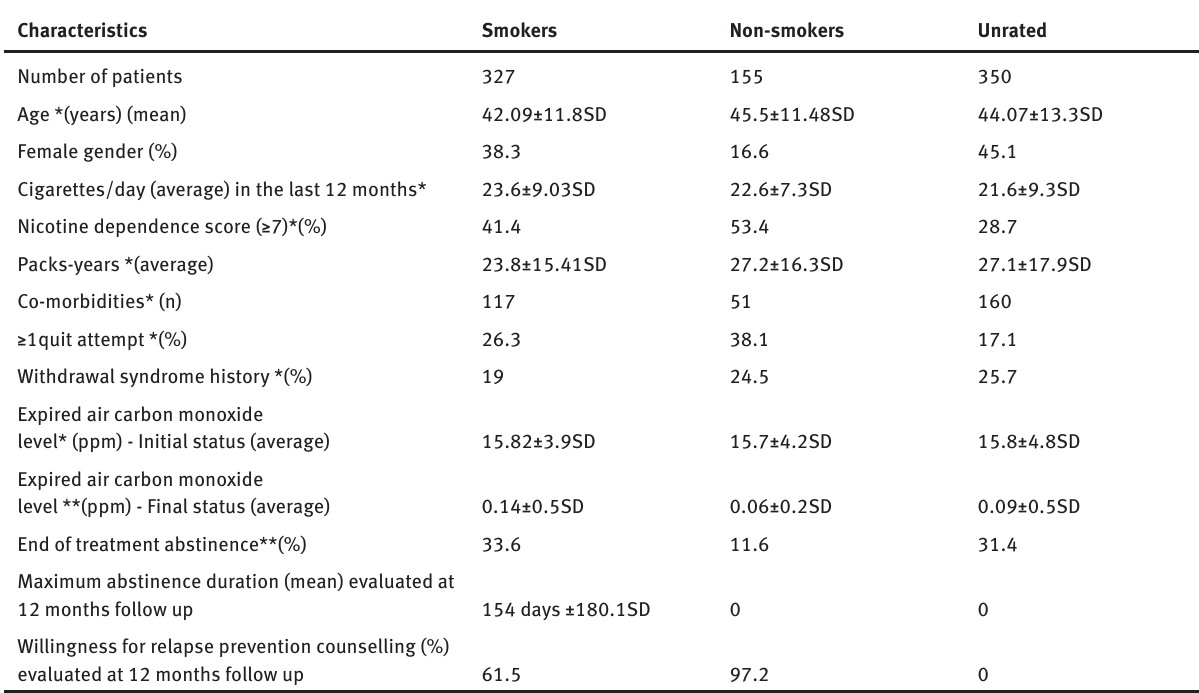
Table 2: Characteristics and smoking status at 12 months follow-up